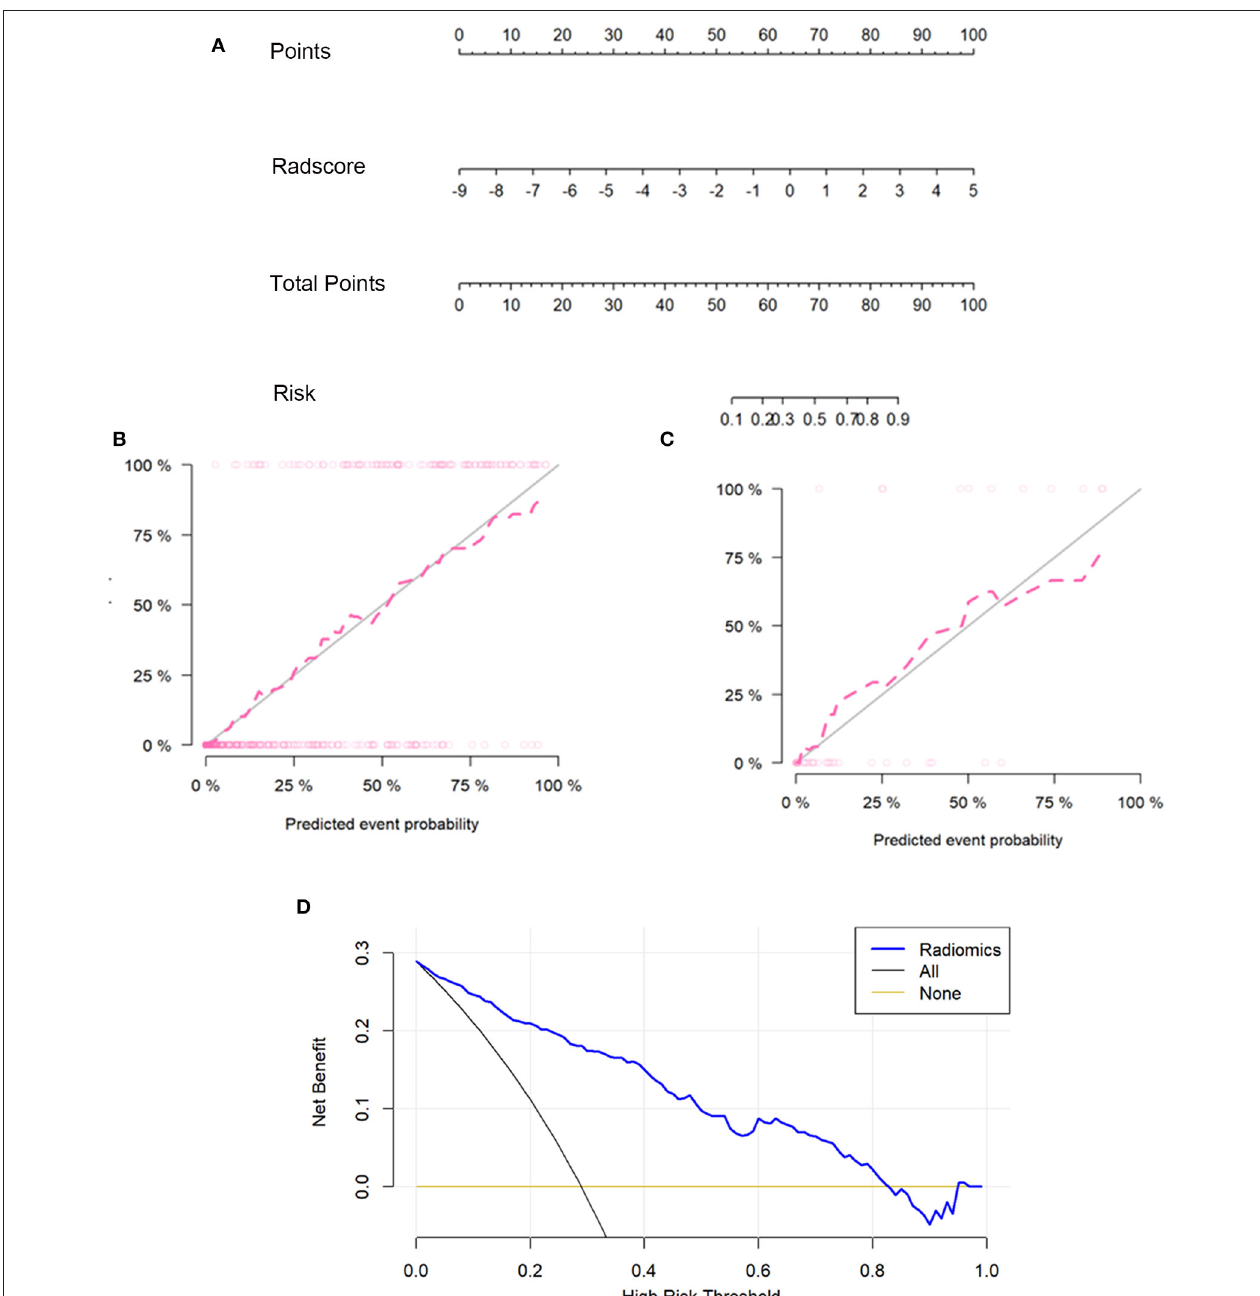
FIGURE 3 | The radiomics nomogram, the calibration curves, and the decision curves. A radiomics nomogram was developed in the training set according to the radiomics score (A) . In the nomogram, radscore corresponded to a point due to it being a graph of a single factor; the point was the same as the total point, and the total point corresponded to the risk of COVID-19. Calibration curves of the radiomics nomogram in the training (B) and validation sets (C) . The horizontal axis of the figure was the predicted event probability, which was the probability of occurrence of the events forecasted by the prediction model, and the vertical axis was the actual event probability, which was the actual event rate of patients. The red line was the fit line and represents the actual value corresponding to the predicted value. The gray line was the reference line. The decision curve (D) for the radiomics score. The vertical axis was the net benefit; the horizontal axis was the high-risk threshold probability at a range of 0.0-1.0. The black line represented the hypothesis that all patients had COVID-19 pneumonia. The brown line represented the hypothesis that all patients had influenza viral pneumonia. The blue line represented the DCA of the radiomics nomogram. The decision curves showed that using the radiomics nomogram in the current study to predict COVID-19 pneumonia had more